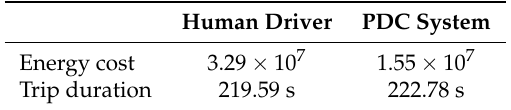
Table 3. Comparison of energy cost and trip duration for the baseline test and the optimal trajectory from predictive cruising control (PCC).